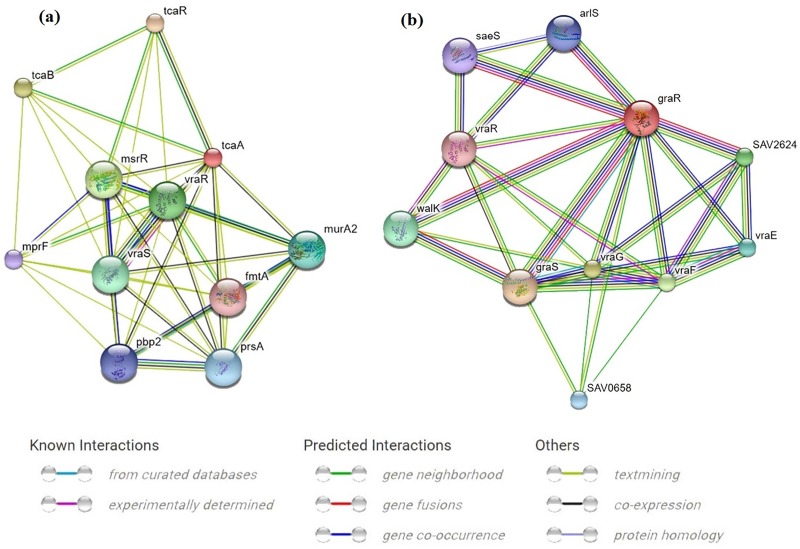
Protein network analysis of selected cell wall biosynthesis regulating genes.a) protein-protein interaction analysis of tcaA and tcaB; b) protein-protein interaction analysis of vraR, vraS, graS, and graR.